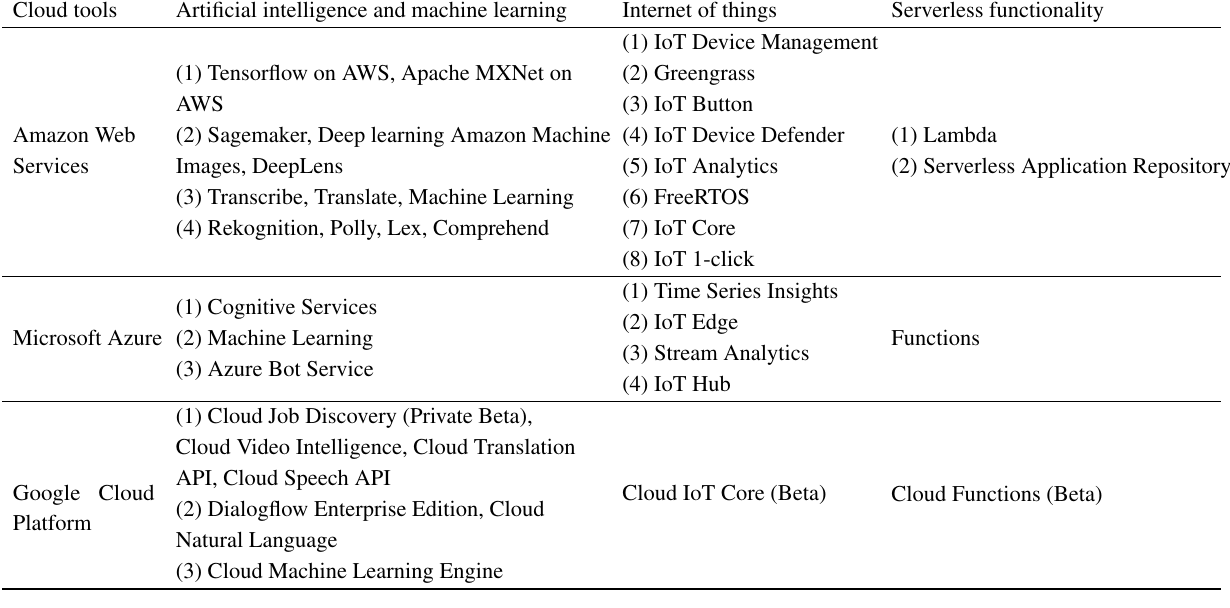
Table 6 Comparison of tools from various cloud vendors.